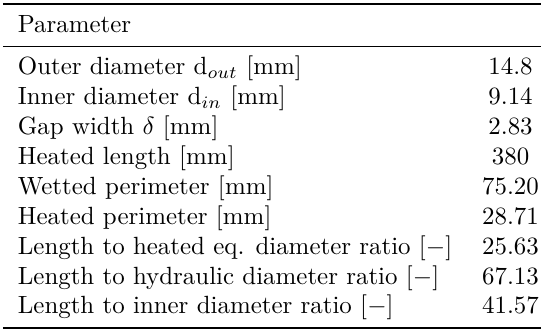
Table 1. The details of test annulus geometry.